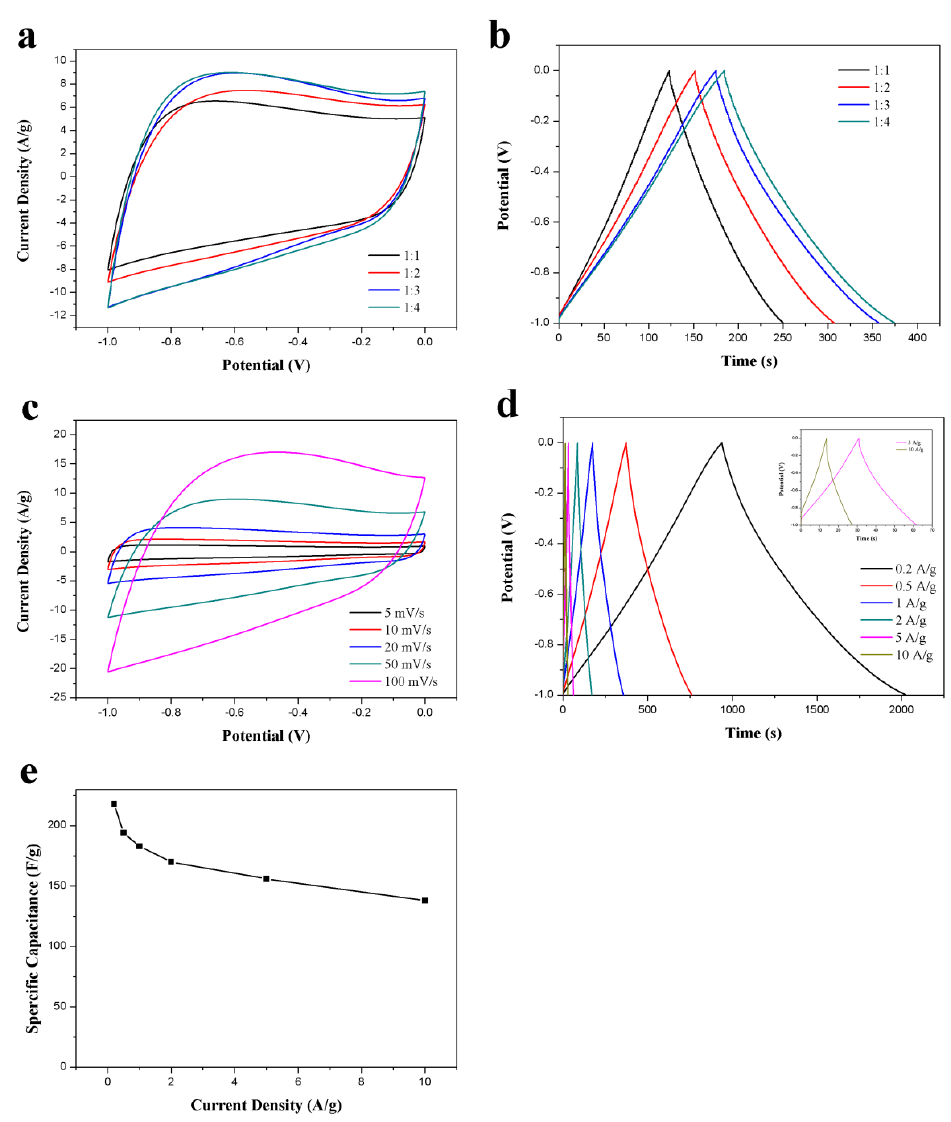
Figure 5. ( a ) CV curves (50 mV/s) and ( b ) GCD curves (1 A/g) of the activated samples obtained at different mass ratios of carbon spheres to ZnCl 2 ; ( c ) CV curves of the ACS-ZnCl 2 at different scan rates, ( d ) GCD curves and ( e ) specific capacitances of the ACS-ZnCl 2 at different current densities. All measurements were performed in 6 M KOH in three-electrode